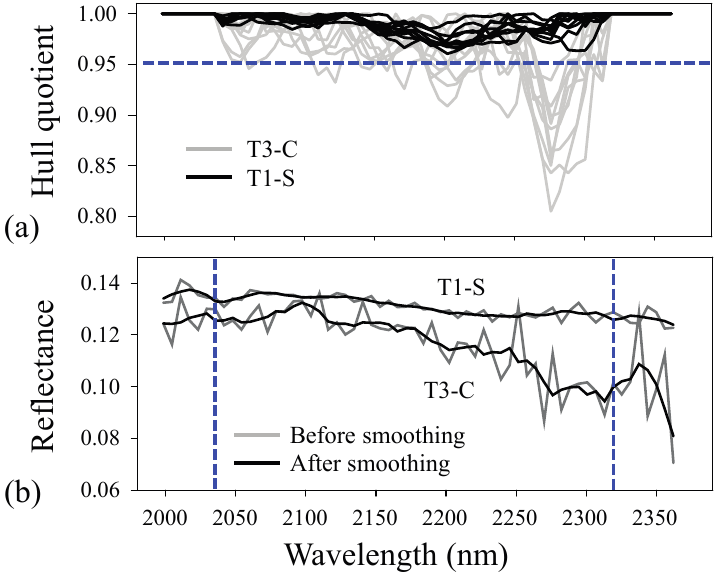
Figure 5. Hull quotients and reflectance spectra extracted from images T1-S and T3-C. Spectra ( n = 10) were randomly-selected from a population of pixels identified as having a wavelength of 2276 nm in image T3-C. ( a ) Hull quotients spectra are of the same pixels from images T1-S and T3-C. The horizontal dashed line is the value of the depth threshold set for the extraction of absorption features; ( b ) Example reflectance spectra taken from (a), before and after smoothing. The vertical dashed lines delineate the spectral range over which the continuum was removed prior to automated feature extraction (AFE). Note the absence of coherent absorption features in smoothed and unsmoothed spectra from image